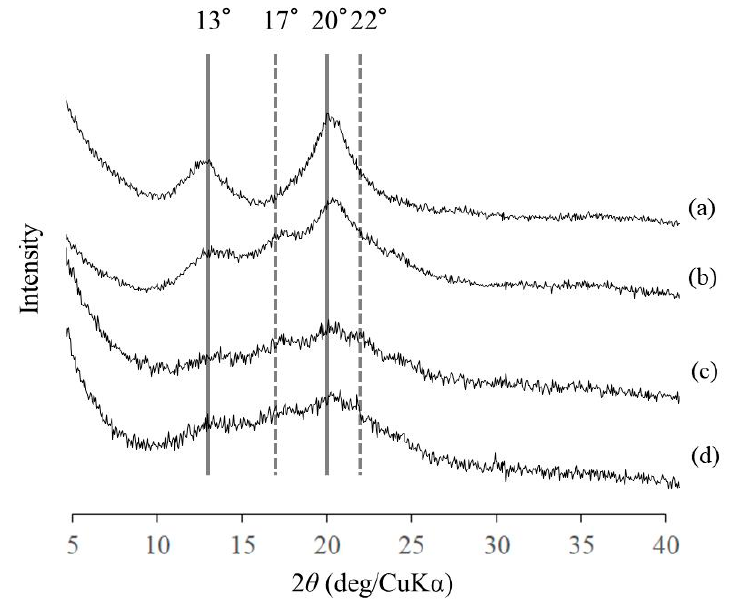
Figure 3. XRD profiles of products by lyophilization of run 2 with reaction times of ( a – d ) 0.5, 1, 3, and